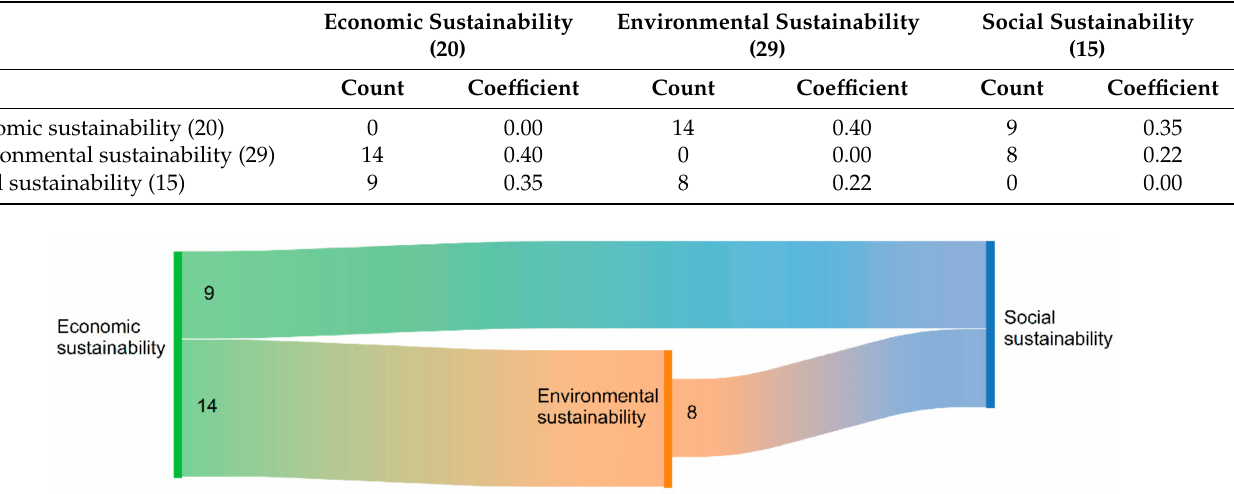
Figure 4. Diagram of relationships between the findings considered advances in the sustainability category based on the review of scientific articles on multi-storey timber